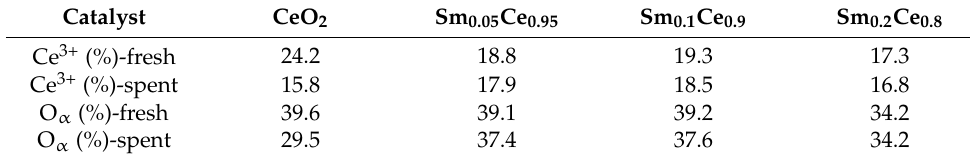
Table 2. Ce 3+ percentages and O α percentages of fresh and spent catalysts.